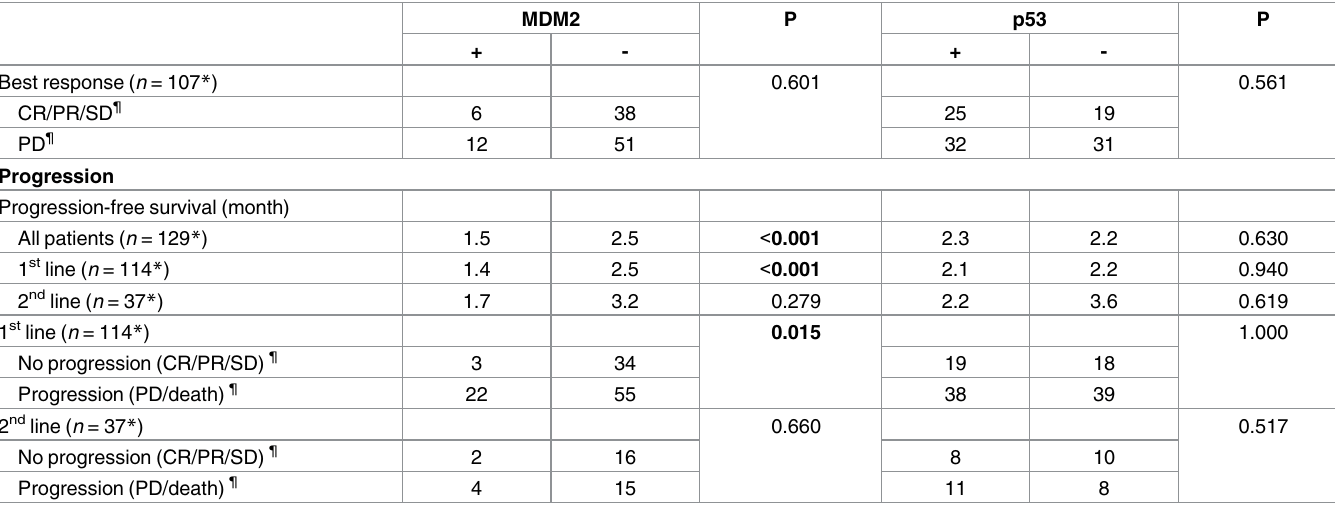
Table 4. MDM2 and p53 status versus chemotherapy response and